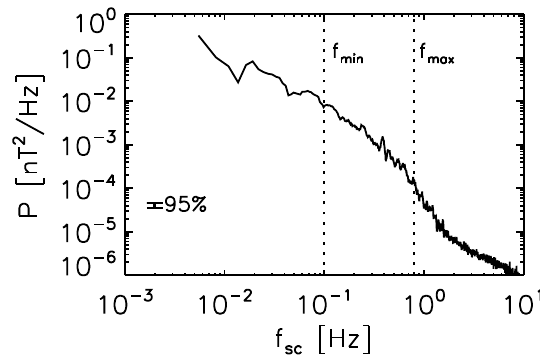
Figure 1. Frequency spectrum for magnetic field fluctuation in the solar wind measured by Cluster-1 on 11 February 2002, 15:29– 15:38UT, from the kinetic-wave database in Perschke et al. (2014). The lower and the upper border frequencies for the wave analysis are indicated by as f min and f max